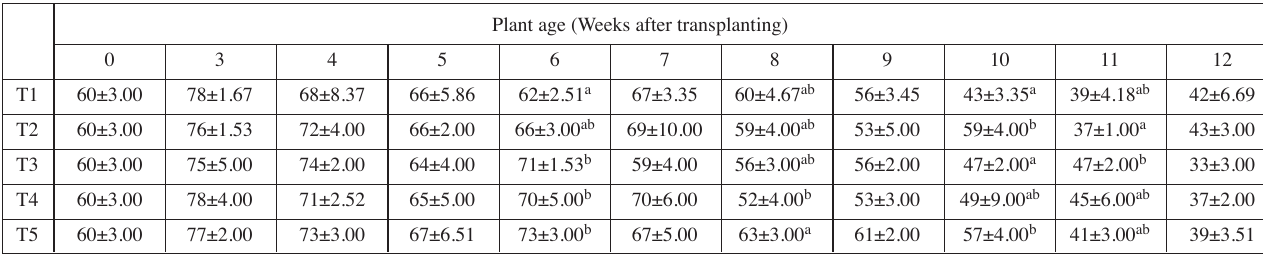
Tab. 5a: Effect of organic and inorganic fertilisers on Zn (mg/kg) of Solanum nigrum L. cultivated in the field